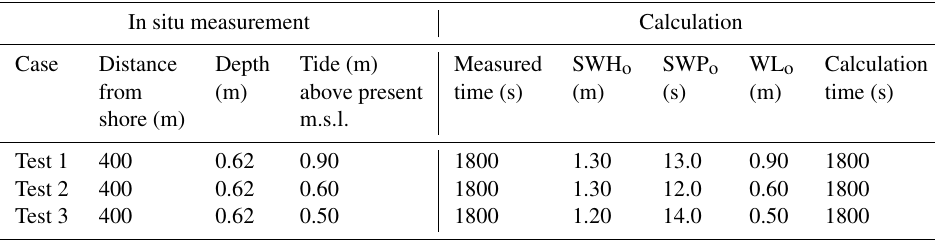
Table 2. In situ Measurements and calculation conditions of water level and wave height for validation. In situ measurement Calculation Case Distance Depth Tide (m) Measured SWH o SWP o WL o Calculation from (m) above present time (s) (m) (s) (m) time (s) shore (m) m.s.l. Test 1 400 0.62 0.90 1800 1.30 13.0 0.90 1800 Test 2 400 0.62 0.60 1800 1.30 12.0 0.60 1800 Test 3 400 0.62 0.50 1800 1.20 14.0 0.50